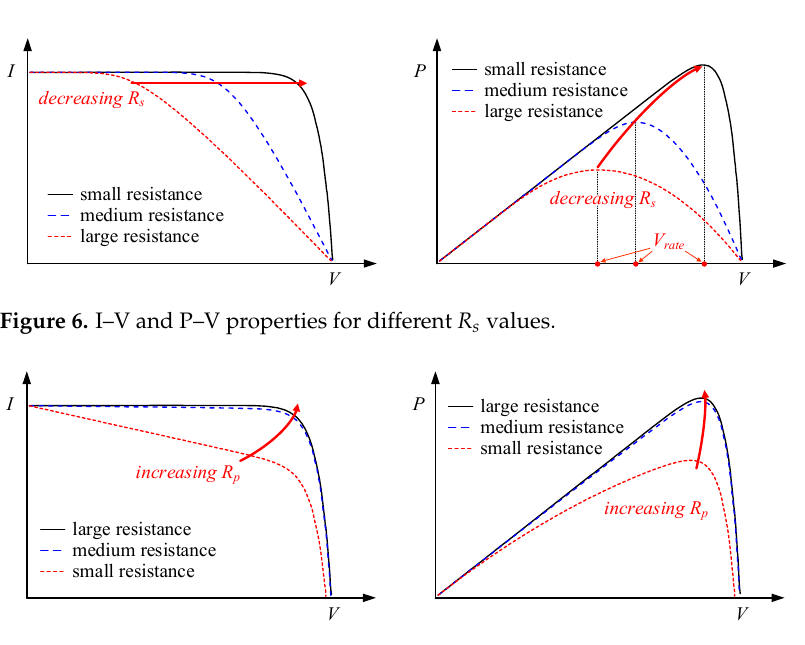
Figure 7. I–V and P–V properties for different R p values.